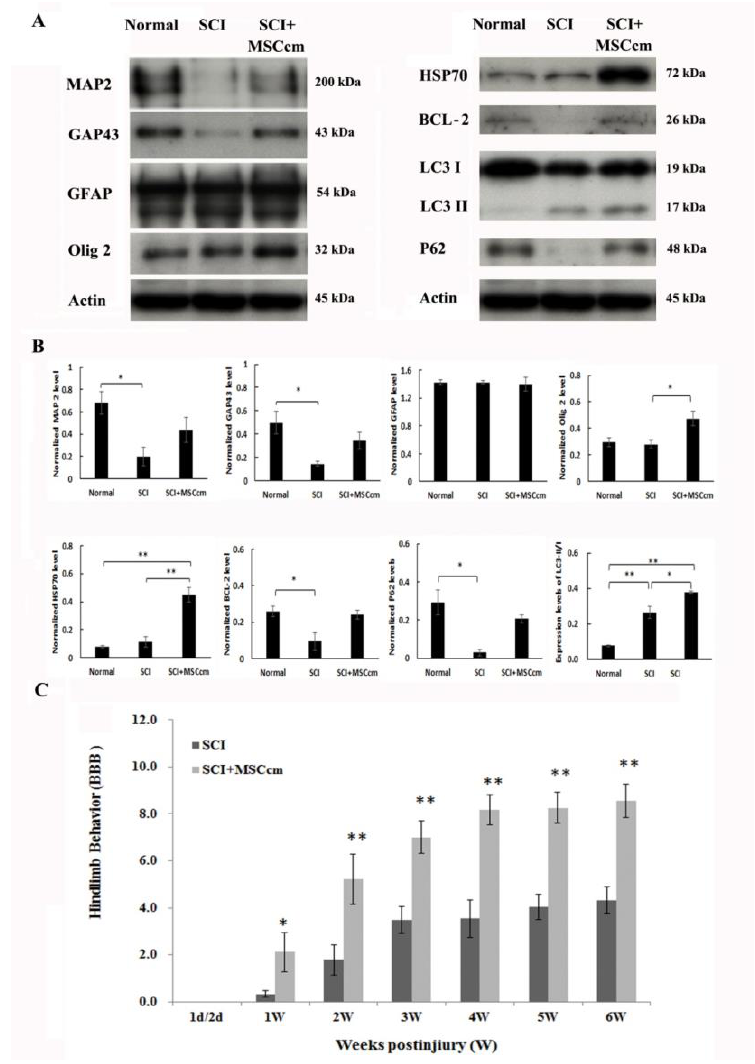
Figure 4. Expression of protein levels in spinal cord of rats and the hindlimb functional behaviors in SCI rats. ( A ) The protein expression levels, determined by Western blot analysis, in normal or injured epicenter of SCI rats at 7 days after the contusion injury. Representative blots are shown. ( B ) The bar graphs show the quantitative analysis of the protein expression relative to actin. Results were means ± SEM ( n = 3 rats each). ( C ) Time course of hindlimb locomotor recovery in rats receiving saline or MSCcm after contusive injury. The time course changes of BBB in SCI rats that were administered saline or BM-MSCcm through tail vein injection. The hindlimb recovery of the animals was assessed in a double-blind manner. Locomotor recovery of SCI rats was evaluated over a 6-week period, using a 21-point scale (Basso, Beattie, Bresnahan (BBB) locomotor rating scale). The results are reported as mean ± SEM. Statistical significance was evaluated using one-way ANOVA and Bonferroni’s t -test. * p < 0.05, ** p < 0.01.